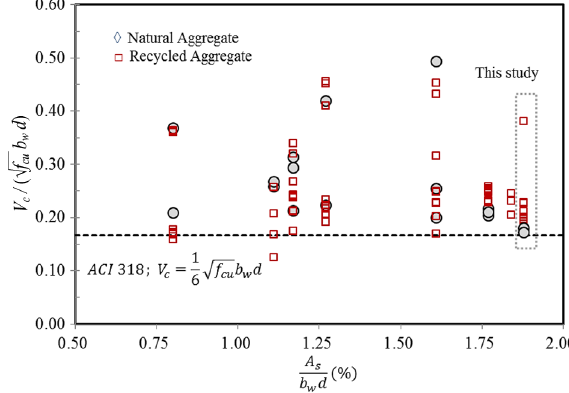
Fig. 6. Shear strength in terms of aggregate type (Lee, Yun 2007)